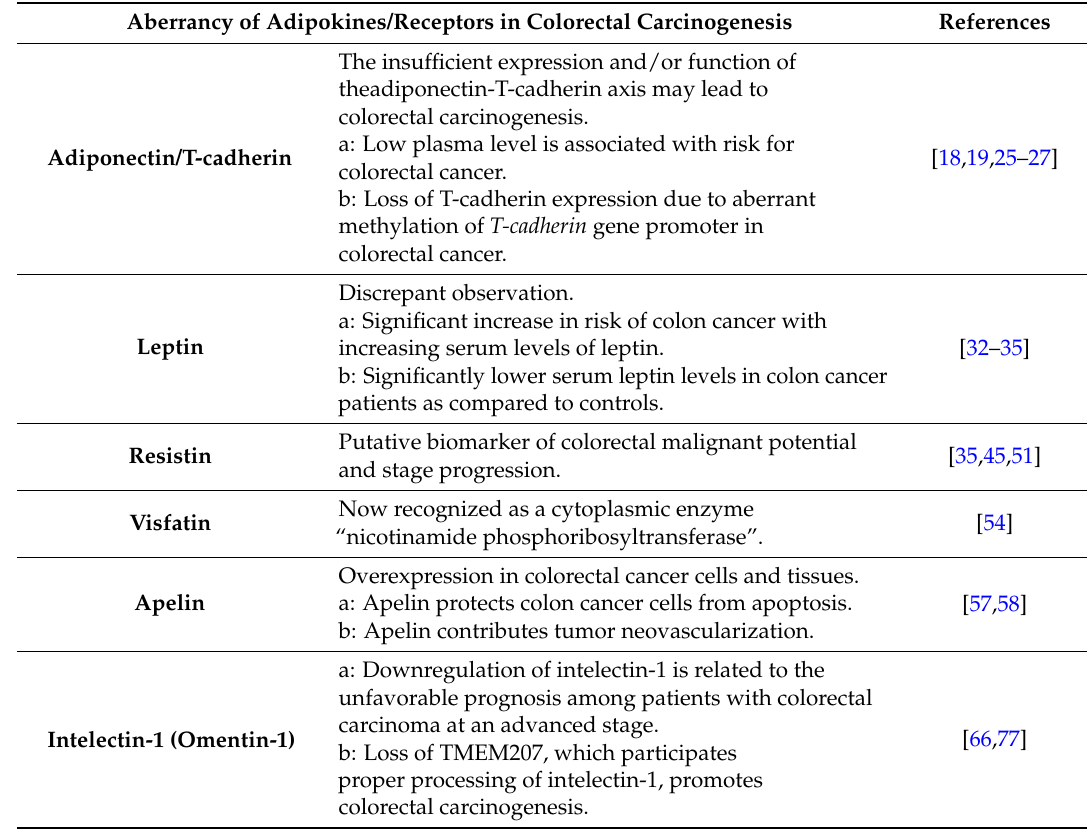
Table 1. Representative carcinogenesis related adipokines and receptors in colorectal cancer. Aberrancy of Adipokines/Receptors in Colorectal